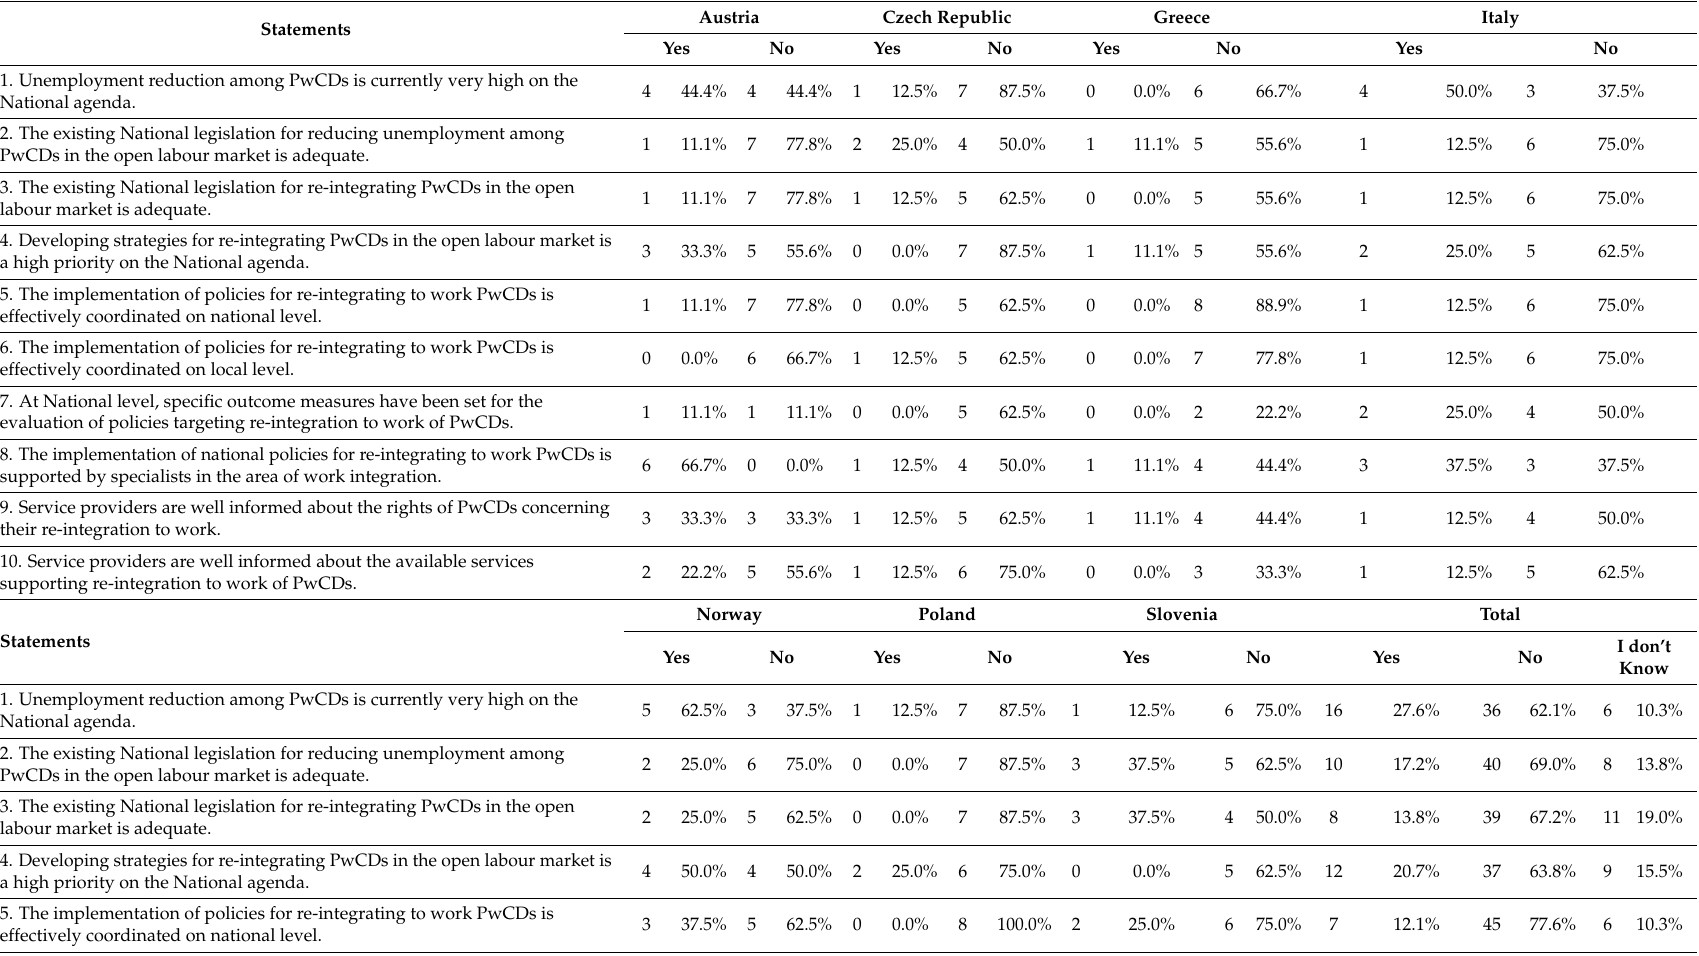
Table 2. Views on the availability of work re-integration strategies by country ( n ,